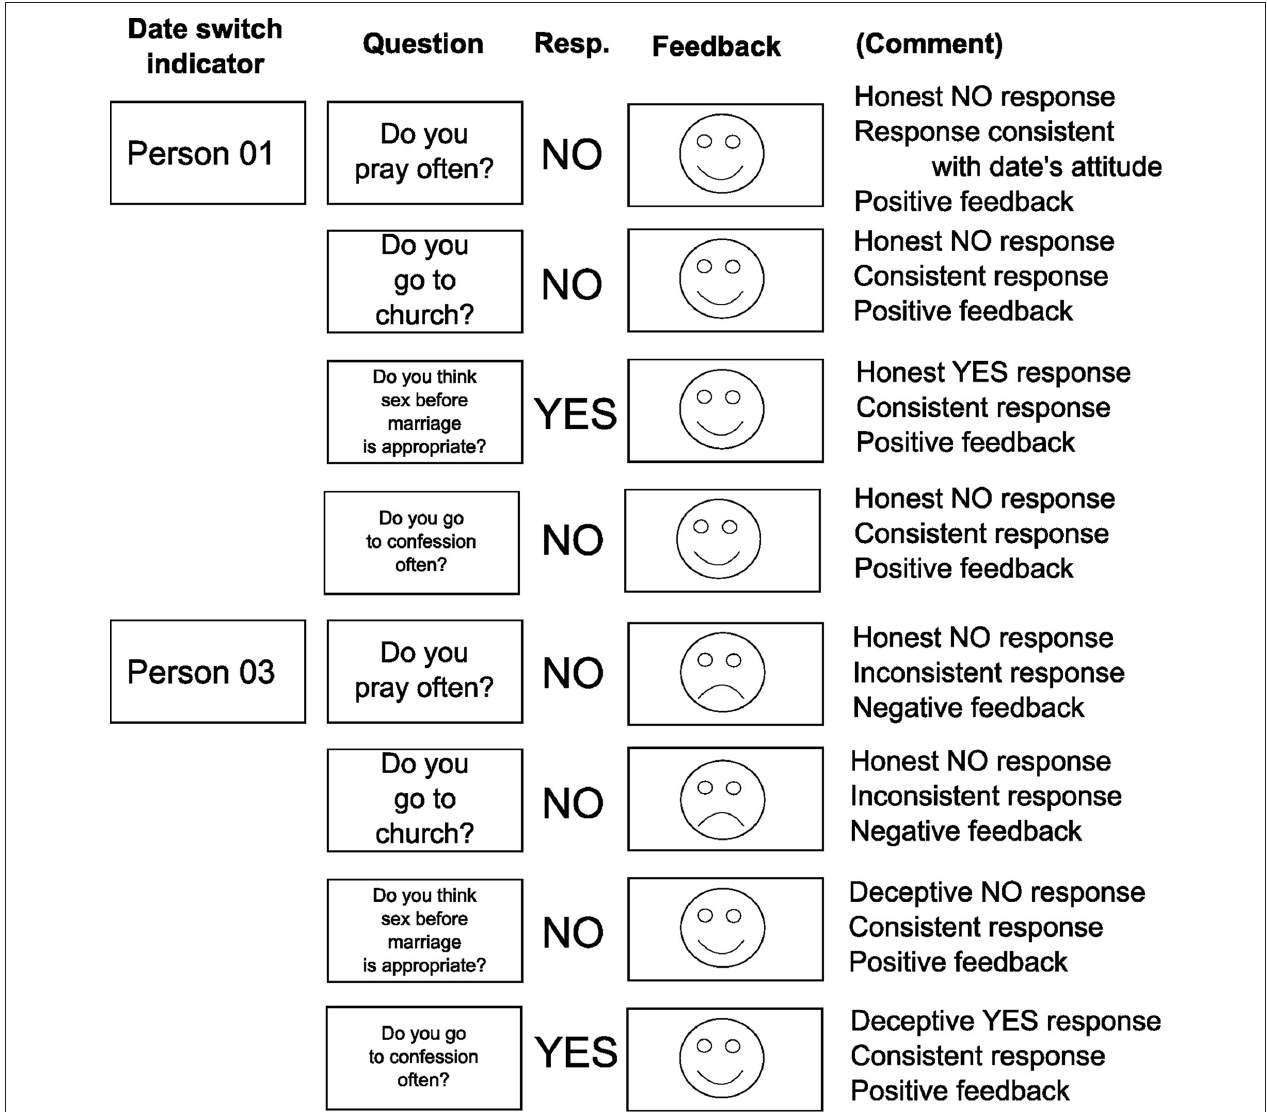
FIGURE 1 | Speed-Dating Task. Two representative questions and feedback messages for two different dates. The subject participating in the SDT is an atheist, not participating in any kind of religion. Person 01 is also an atheist with identical attitudes, so every honest response results in positive feedback. However, Person 03 is a faithful catholic, so the feedback following honest responses (questions 1 and 2) is negative, indicating inconsistency. Based on the feedbacks the subject can adjust his responses so that he appears similar to the date (questions 3 and 4). The questions are presented